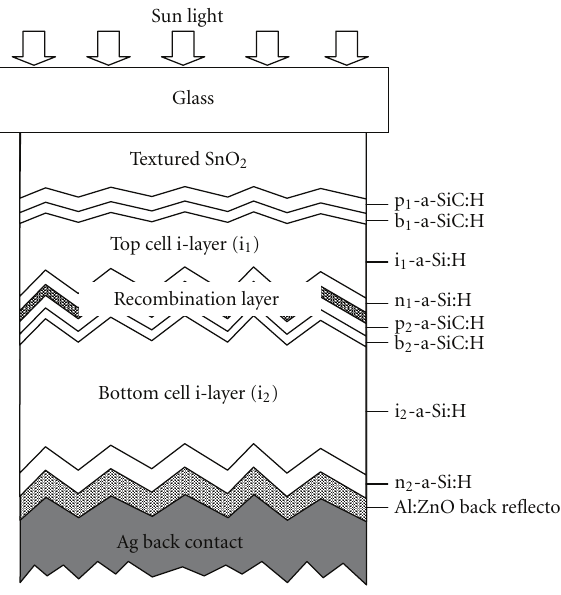
Figure 3: Measured QE of solar cells of sample A, B, and C. Sam-ple A is with the standard n/p junction; samples B has the p + recom- bination layer; sample C has the n + /p + double recombination layer.